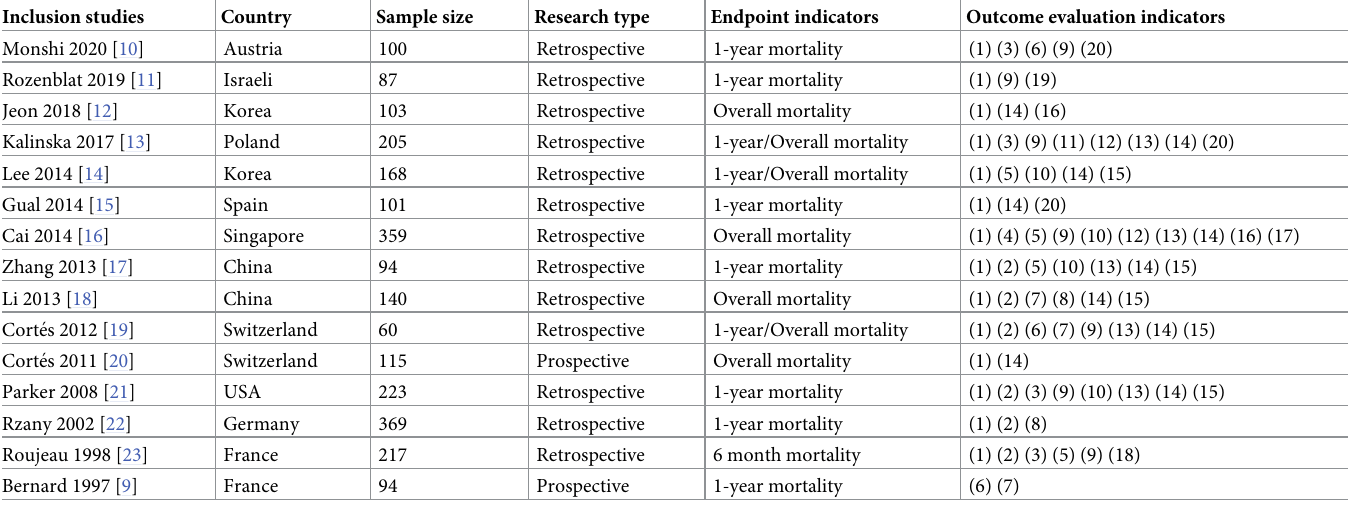
1. Age. As shown in Fig 2, 14 studies [10–23] analysed the association between advanced age and mortality in patients with bullous pemphigoid. In most studies, the median or average age at diagnosis was used as the cut-off value for advanced age, which ranged from 67 to 85 Table 1. The basic characteristics of included